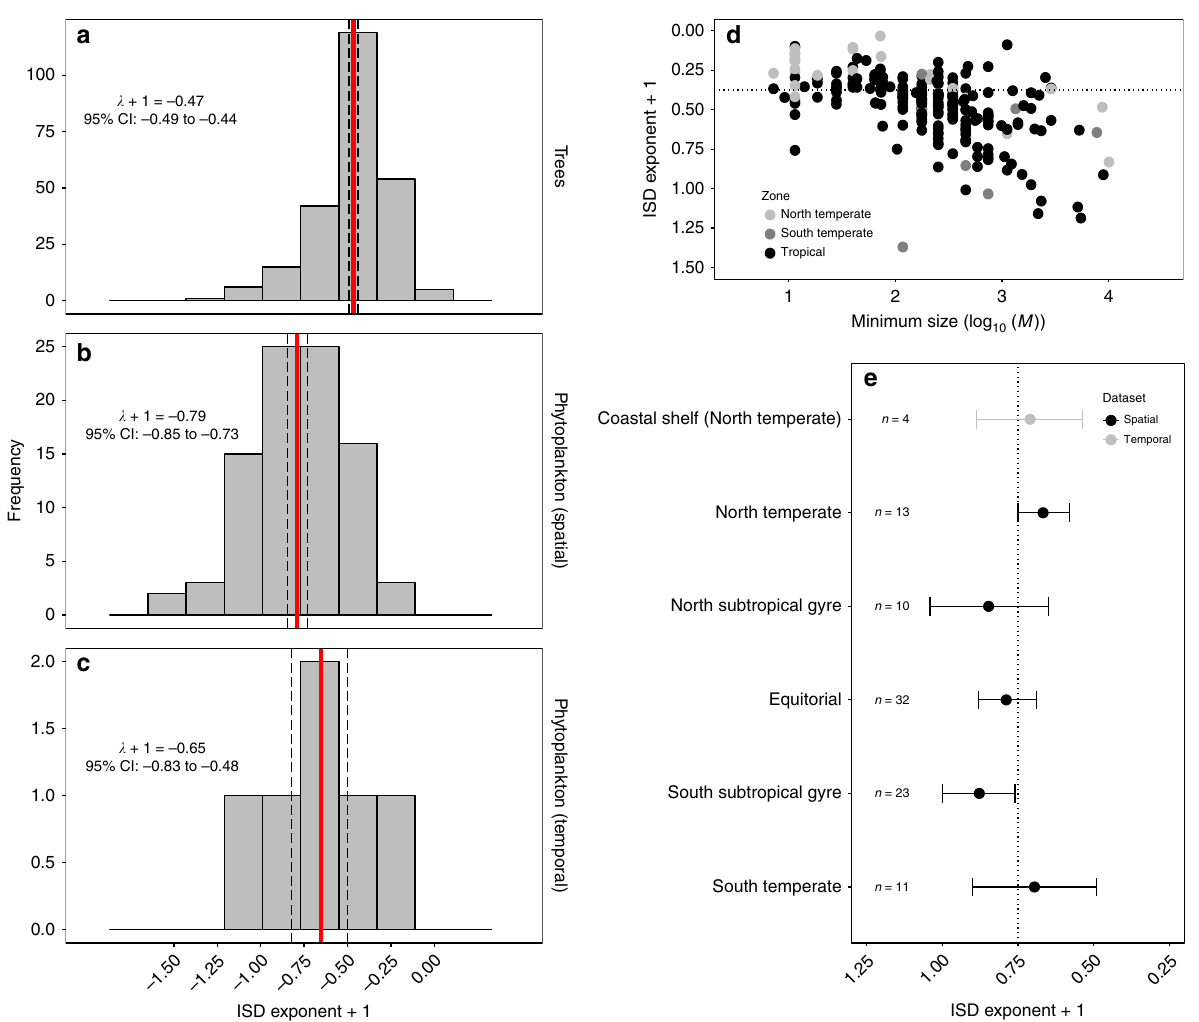
Fig. 2 Individual size distributions differ between phytoplankton and trees and under different environmental contexts. a – c Phytoplankton individual size distribution (ISD) exponents are signi fi cantly larger compared to tree communities highlighting that proportionally more small, relative to large, individuals are found in phytoplankton communities. The mean ISD exponent ( (cid:1) λ þ 1) and 95% con fi dence intervals are indicated in each panel by solid and dashed vertical lines, respectively. d Tree ISD exponents become more negative, and deviate increasingly from the metabolic scaling prediction (dashed line), as the minimum body size in the fi tted power-law distributions increases. Large minimum size values signify signi fi cant deviation from the general power-law scaling function among small size classes and likely re fl ect recruitment limitation due to external disturbances. e A general ISD exponent ( λ þ 1 (cid:3) (cid:2) 0 : 75) is supported among nearly all the major oceanic regions across the globe, consistent with metabolic scaling theory (dashed line). Error bars represent